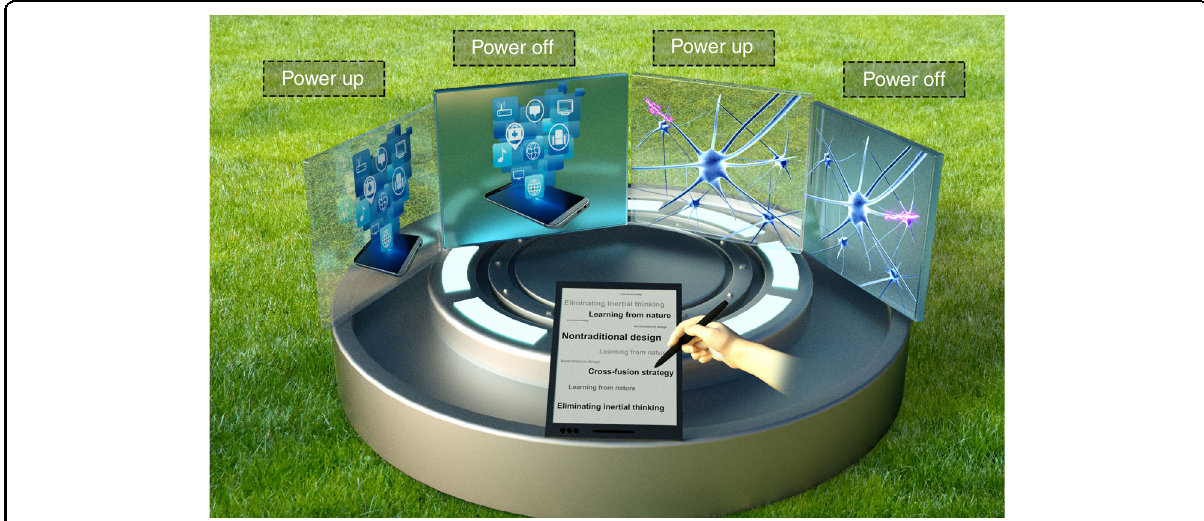
Fig. 5 Research strategy and development of green technologies in the future. Scheme of the green display technologies combined with untraditional